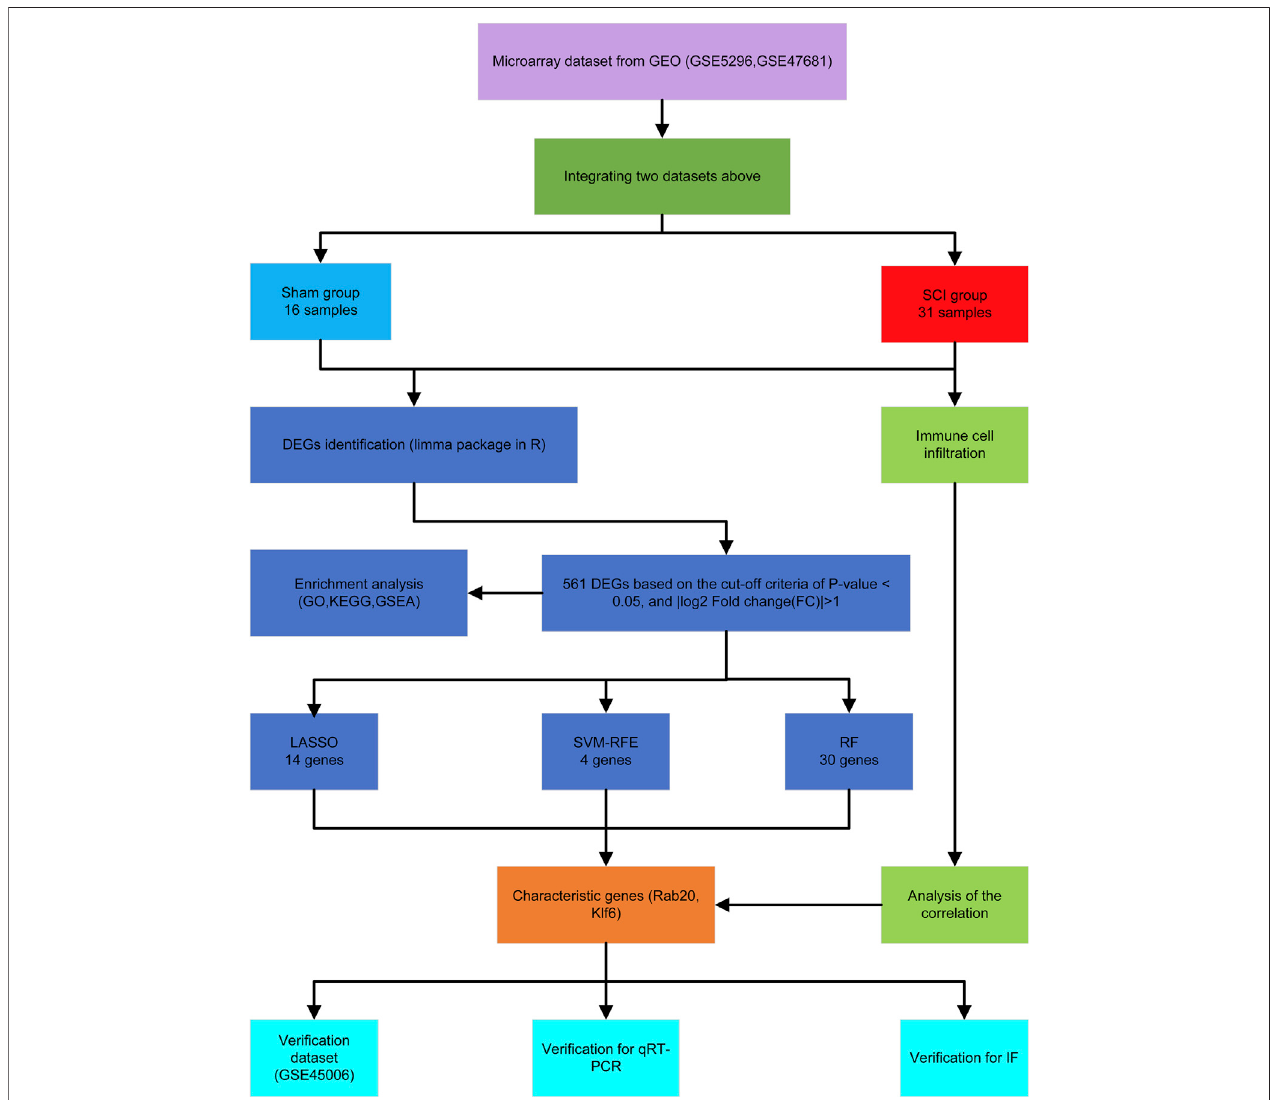
FIGURE 1 | The fl owchart of the analysis